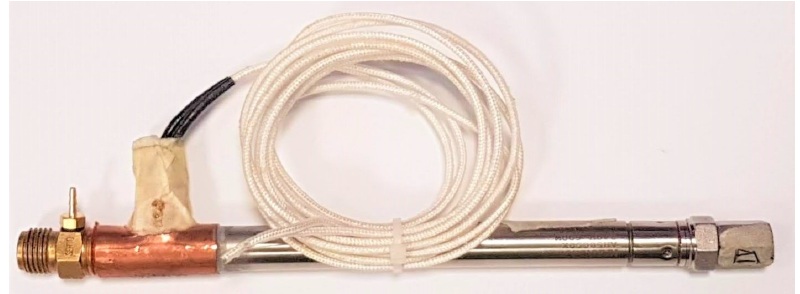
Figure 3. Electrical heater.